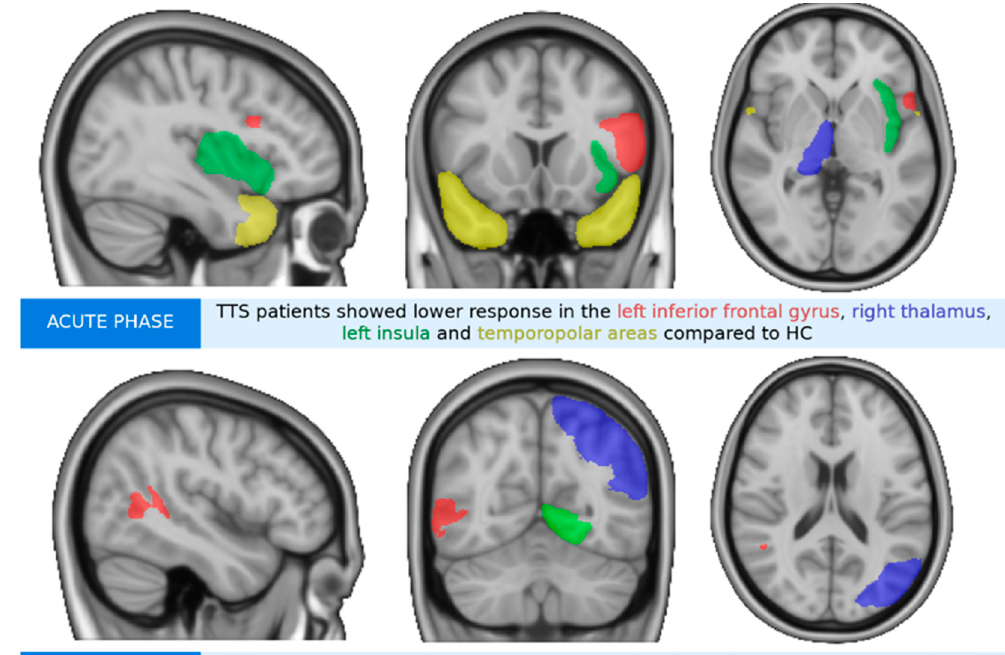
Figure 5. Graphic abstract of the main findings.